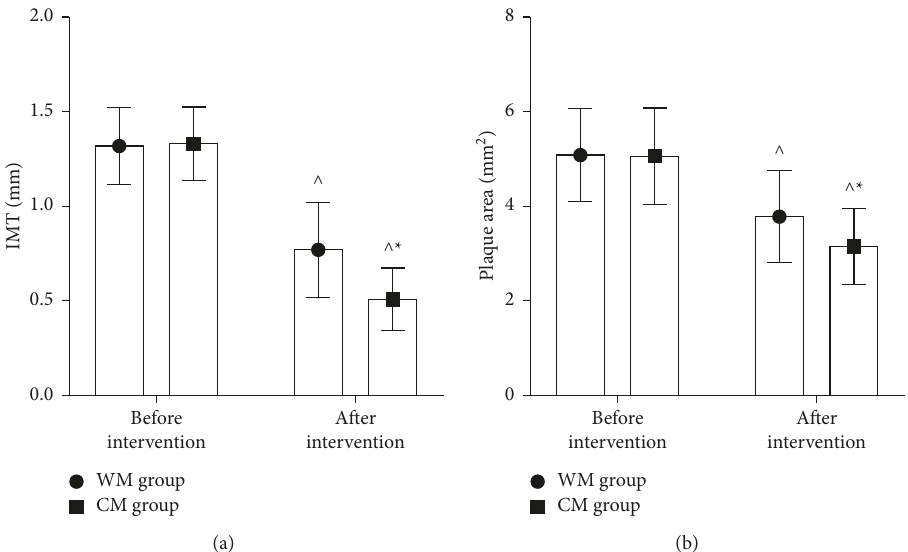
Figure 5: Comparison of IMTand plaque area in both groups. (a) IMT. (b) Plaque area. Compared with the same group before intervention, P 0 . 05; compared with the WM group after ∧ <